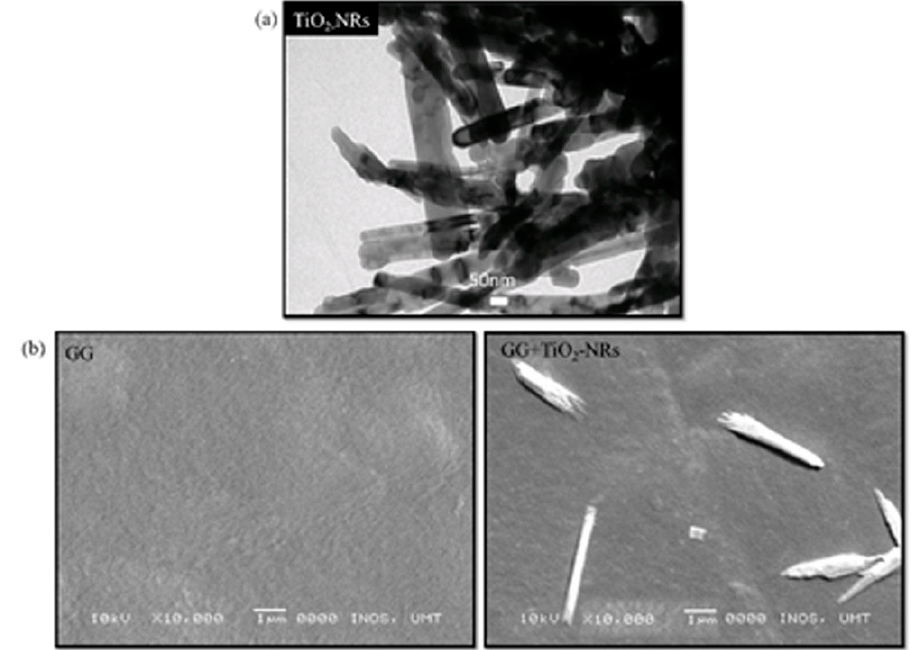
-NRs (b) SEM micrographs of GG and GG+TiO 2